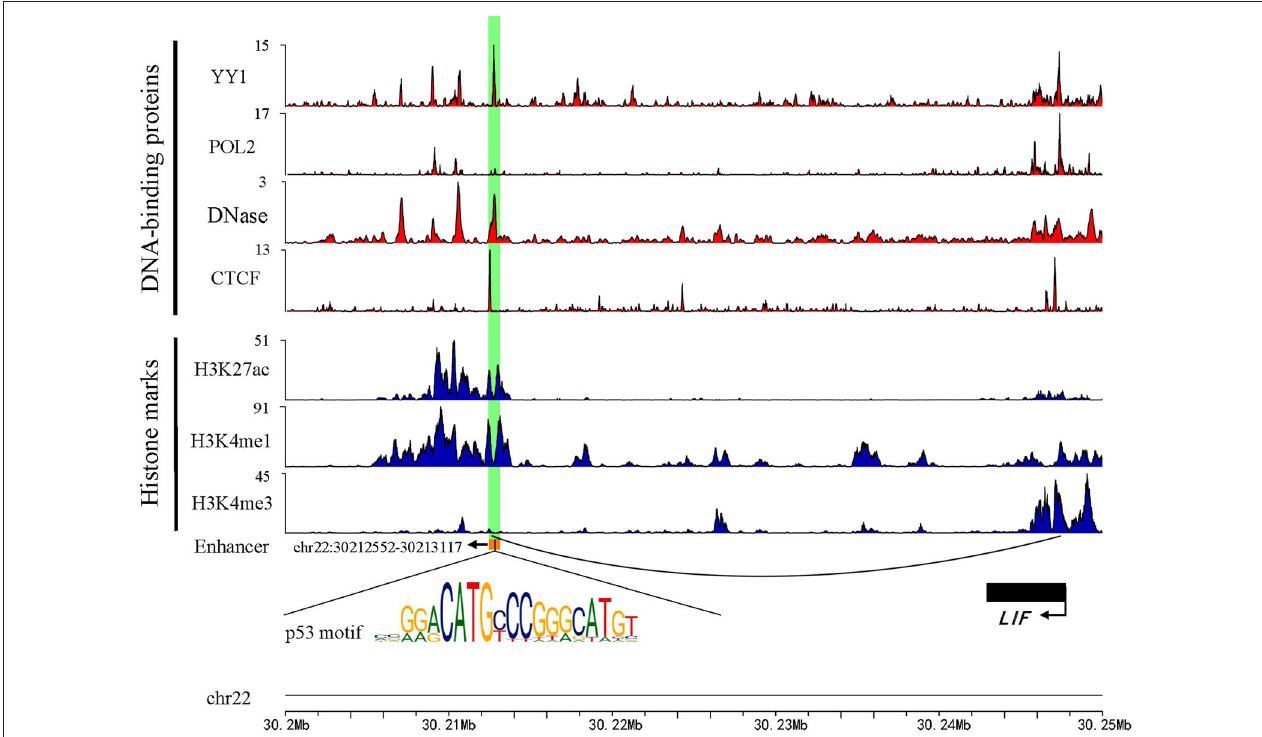
FIGURE 1 | An example genomic map of enhancer chr22: 30212552-30213117. Blue represents the histone modification, red marks the TF binding on the chromosome, and the black arc represents a Topology domain.